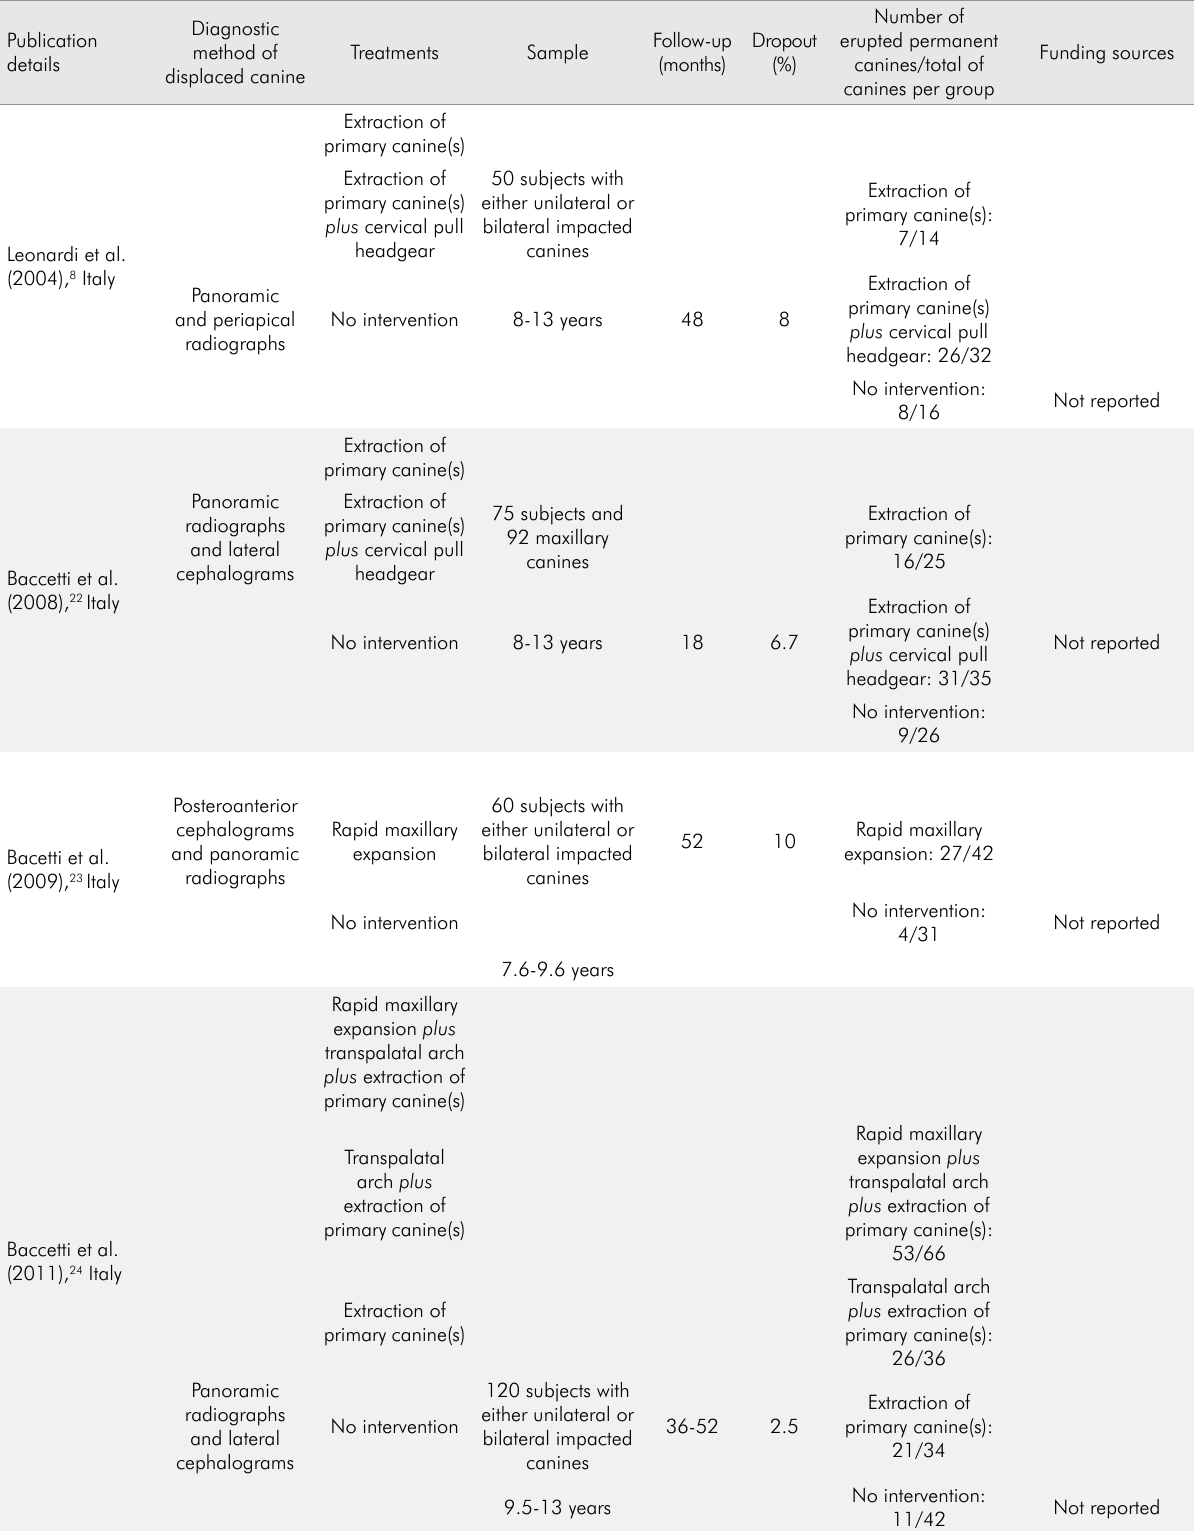
Table 3. Detailed chart related to studies included in the systematic